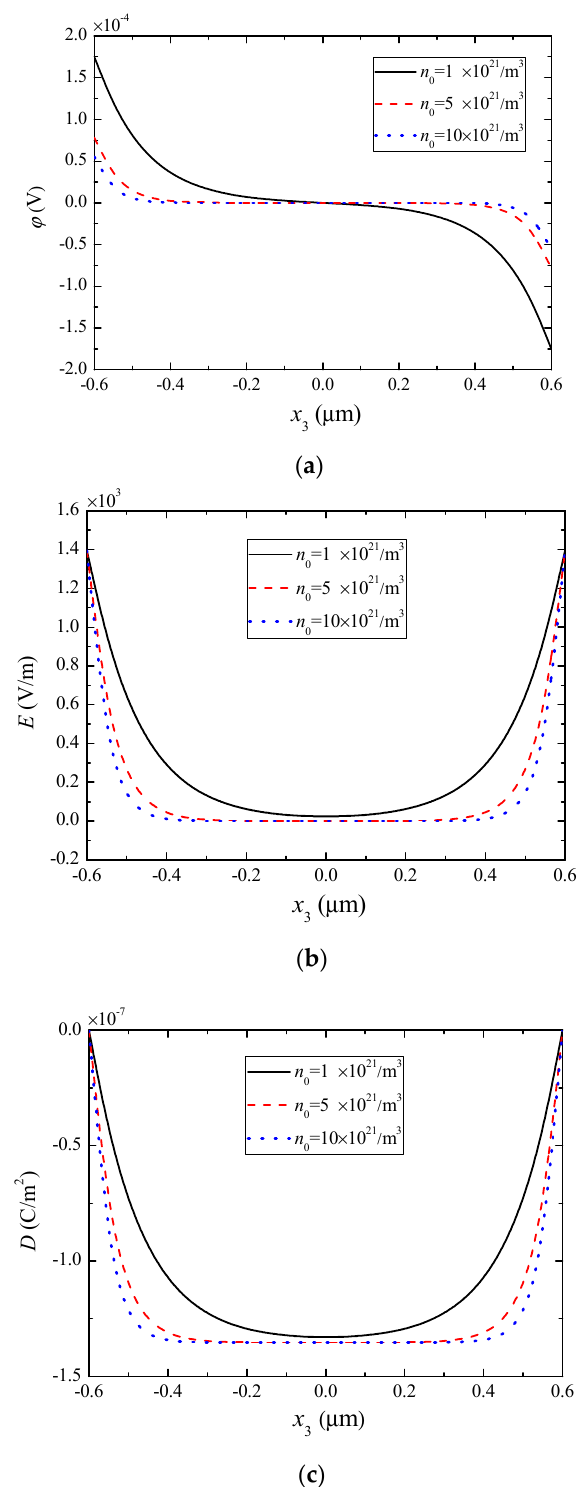
=10 AT ψ − .( a ) Electric 0